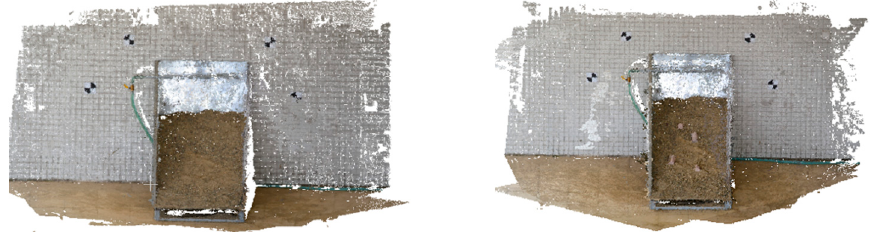
Figure 10. Reconstruction before and after the disturbance.